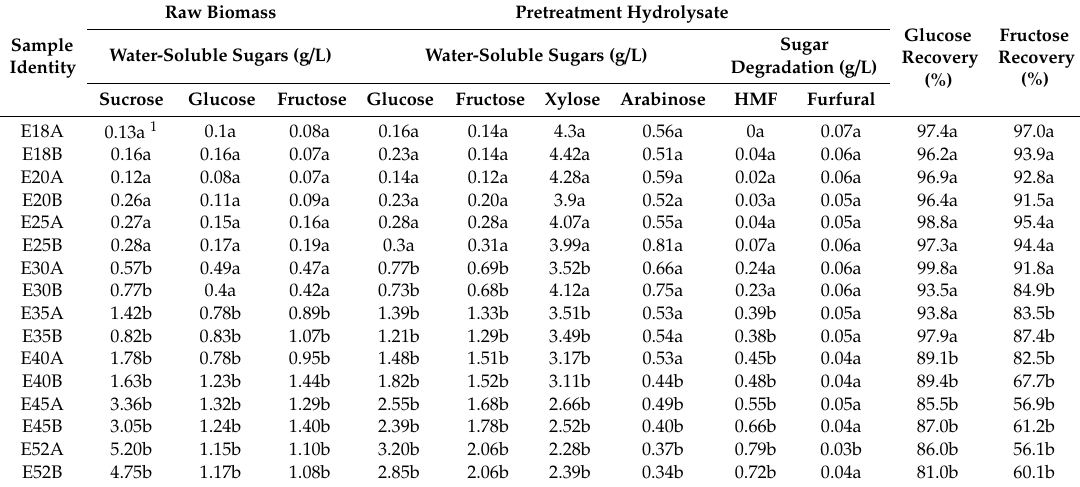
Table 2. Water-soluble sugars in the raw biomass and recovery of sugars after pretreatment.